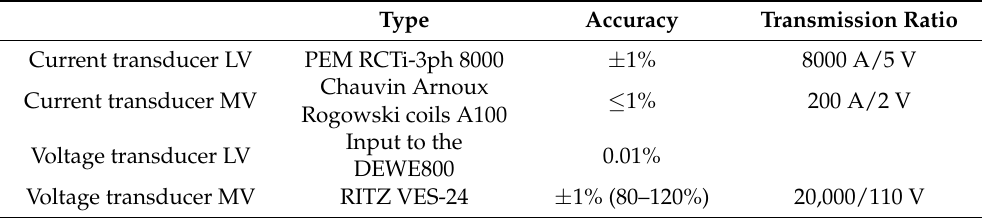
Table 4. Measurement equipment